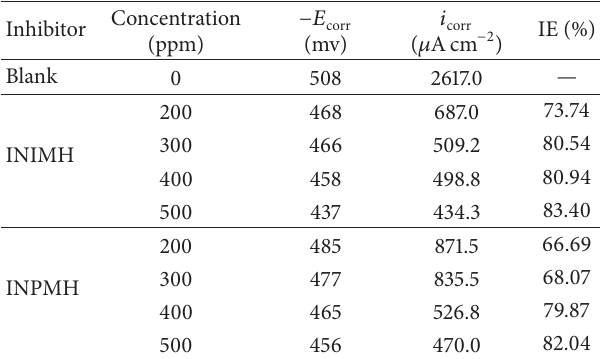
Table 4: Polarization parameters and corresponding inhibition efficiency (IE) for the corrosion of the MS in 0.5 M HCl without and with addition of various concentrations of INIMH and INPMH at 30 ∘